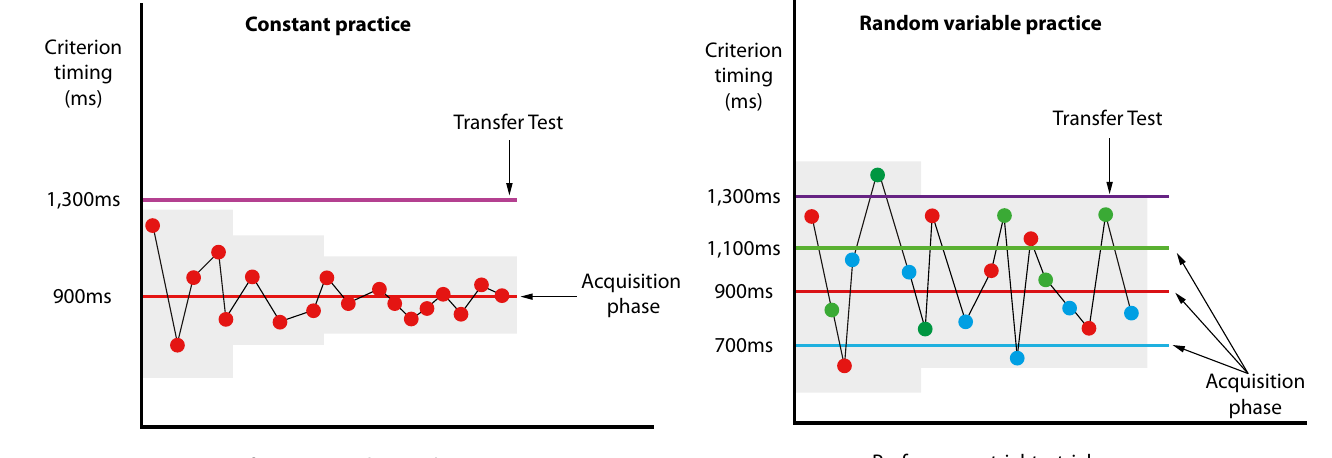
Figure 1 . Constant practice requires different type of processing compared to random practice. Little temporal adjustment based on the error of the last trial occurs only in constant practice. The parameterization during the acquisition phase tends to became closer of the absolute timing criterion (900ms) and distant of the value required in the transfer test (1.300ms). The diminishing of grey range on figure exemplifies it. On the other hand, variable practice requires an ample range of parameterization during all acquisition and induces higher levels of error than constant practice does. The grey range is more ample than in constant practice and does not present significant